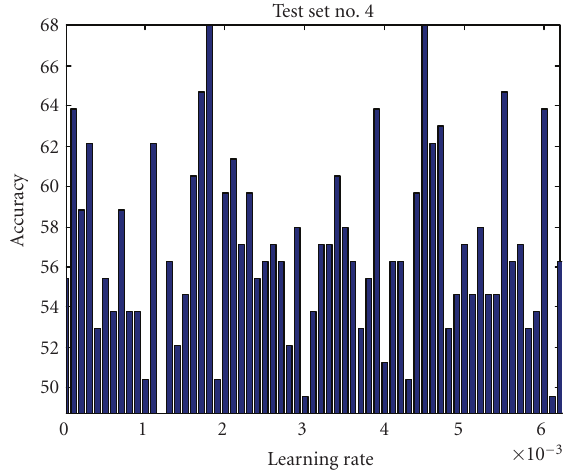
Figure 7: Learning rate impact on algorithm accuracy for test set no. 4 where other parameters are kept